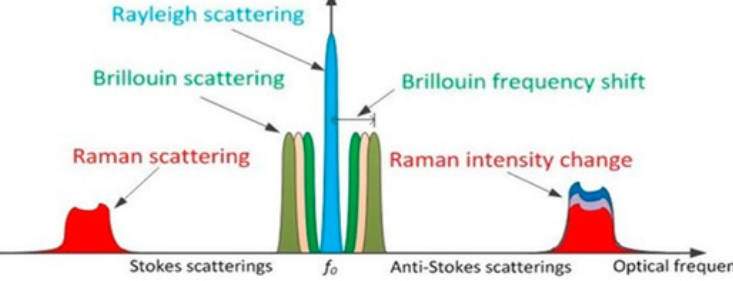
Figure 3. The backscattering phenomenons used for distributed fibre optic sensing. Reprinted from ref.